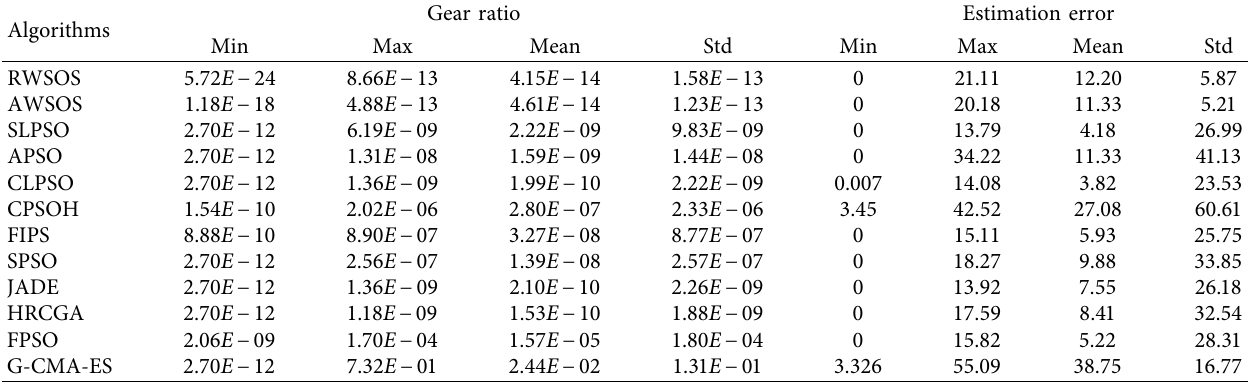
Table 22: Comparison on the frst two design problem.